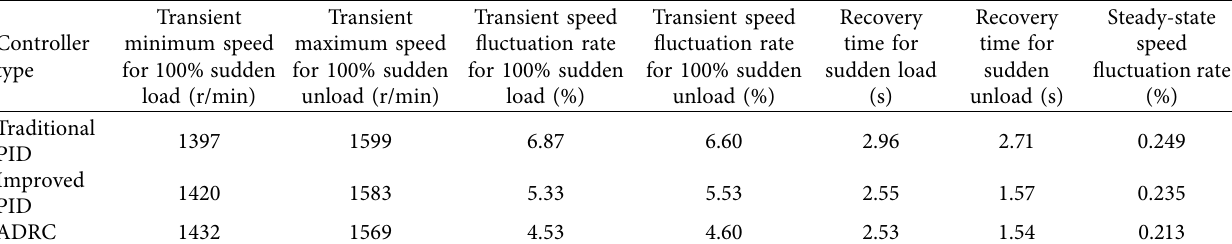
Table 4: Experimental